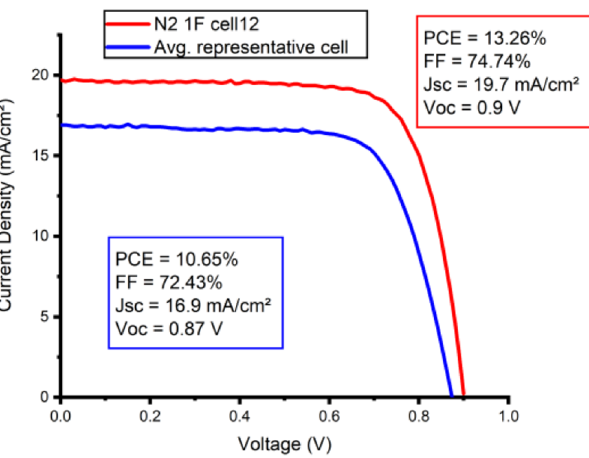
Fig. 8. J – V curve of champion and average-representative cells obtained with low pressure gas quenching. For the average- representative cell, the one with closest performance to the average values was